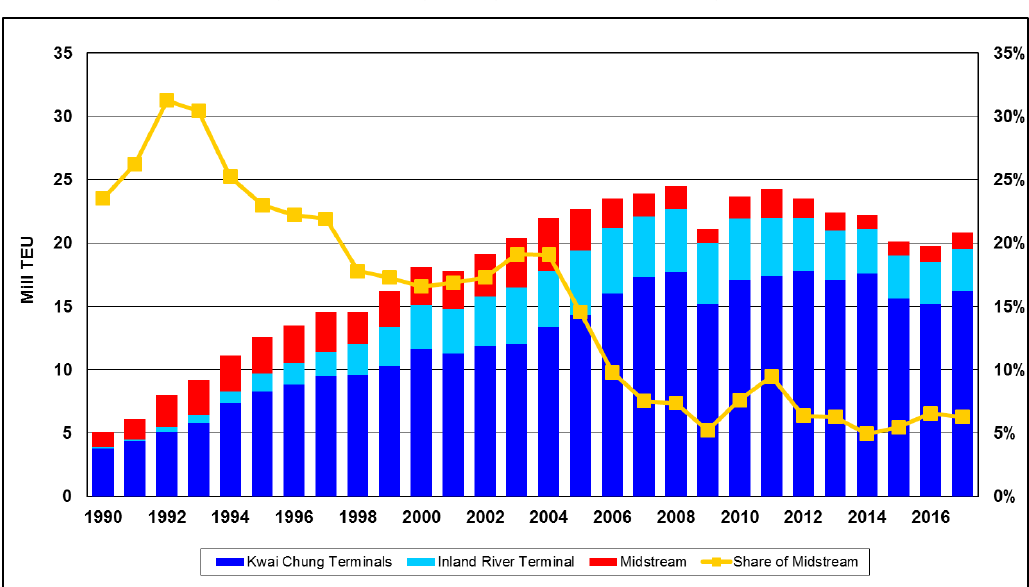
Source: Hong Kong Marine Department,